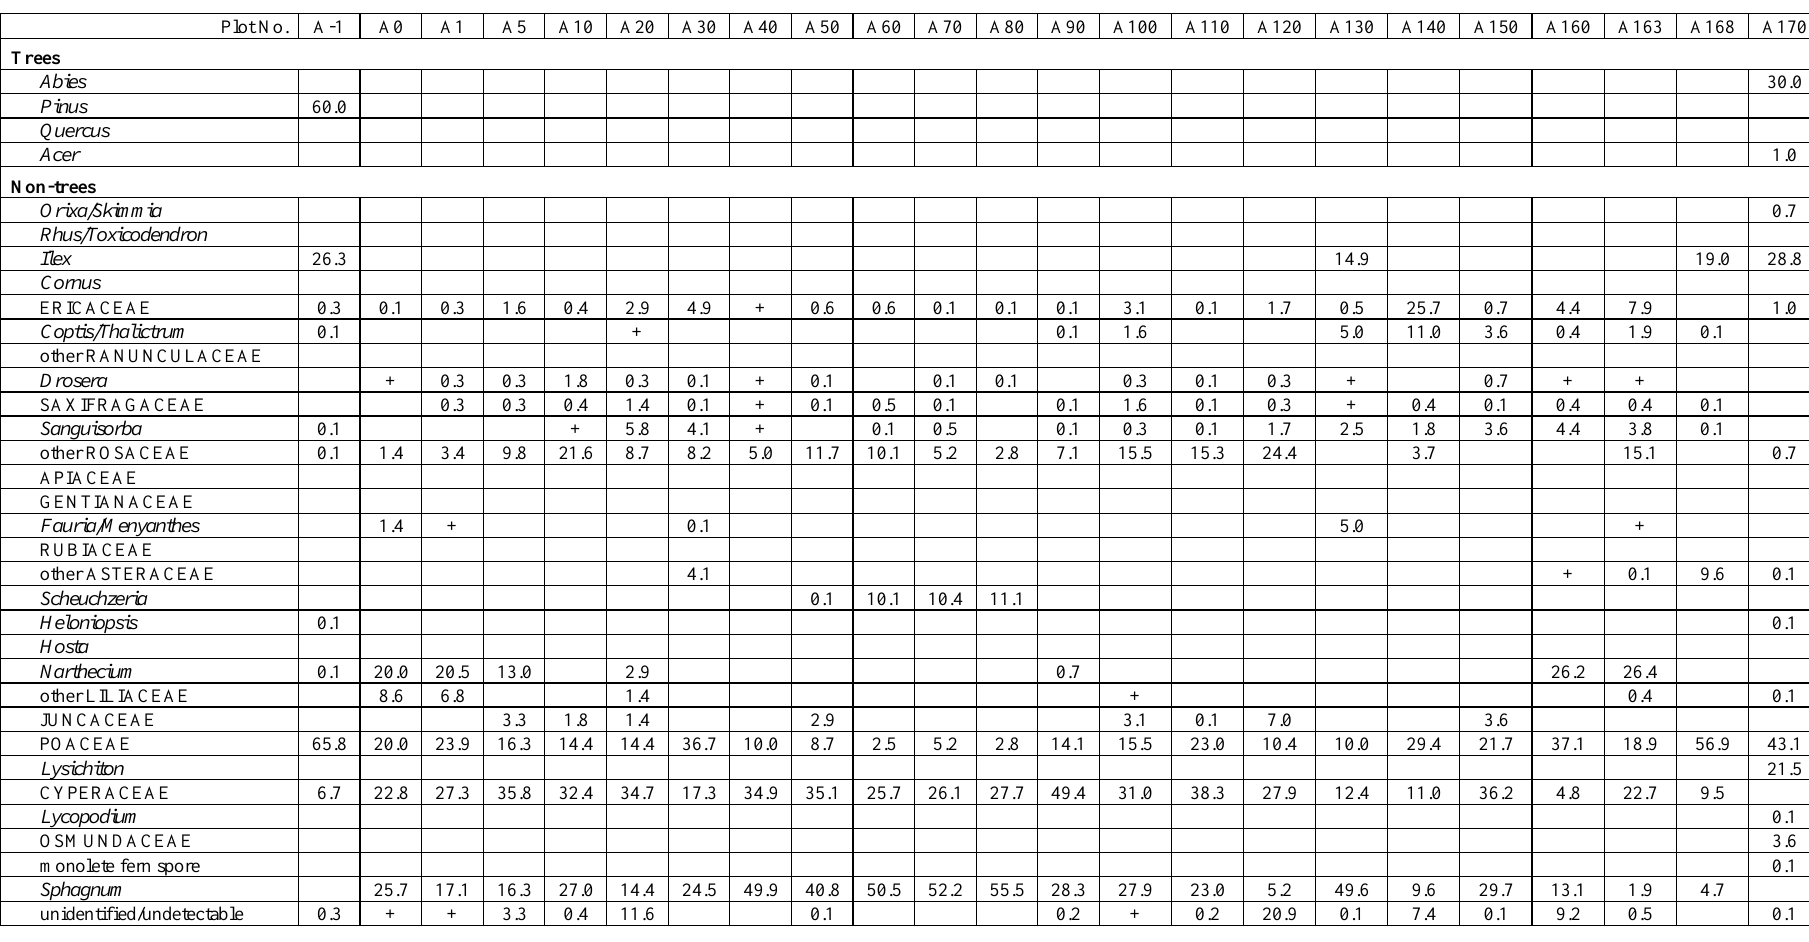
Table A1. Species composition of the plots on Line A in Takada-yachi Mire. The relative cover of each taxon is summarised for those categories coinciding with the pollen type. The extent of species dominance is shown as original percent coverage for trees and relative coverage for non-trees. Plot